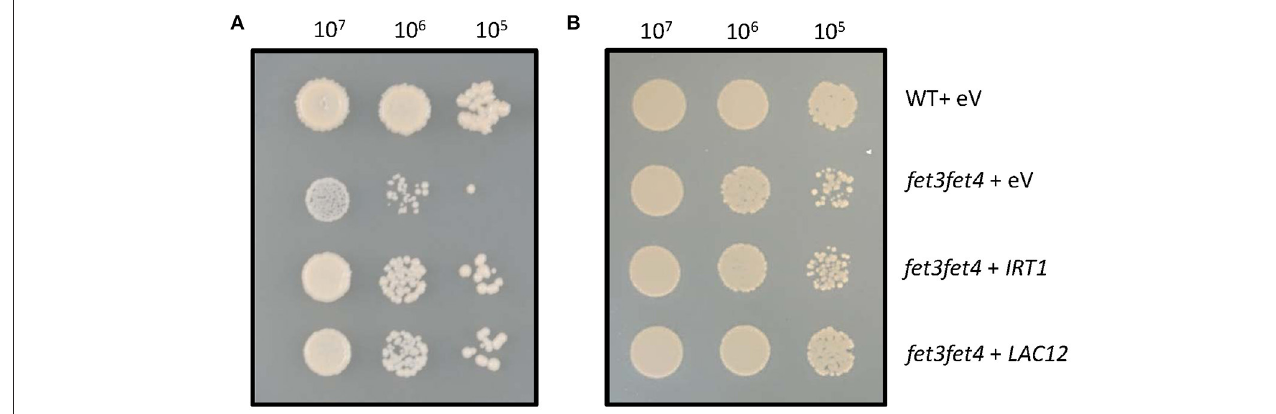
FIGURE 2 | Heterologous expression of the AtLAC12 cDNA complements a Fe uptake-defective fet3fet4 mutant of Saccharomyces cerevisiae . Wild-type and the Fe uptake-defective fet3fet4 mutant of Saccharomyces cerevisiae transformed with the empty vector pFL61 Gateway (eV) or expressing IRT1 or LAC12 cDNAs of A. thaliana , respectively. Aliquots of 10 µ L of 10-fold serial dilutions (starting from OD 600 = 0.3, ca . 10 7 cells ml − 1 ) were spotted on (A) SD-URA medium (pH 5.7) and (B) SD-URA medium (pH 5.7) supplemented with 0.5mM FeSO 4 . Images are representative of three independent transformant colonies from each of two independent